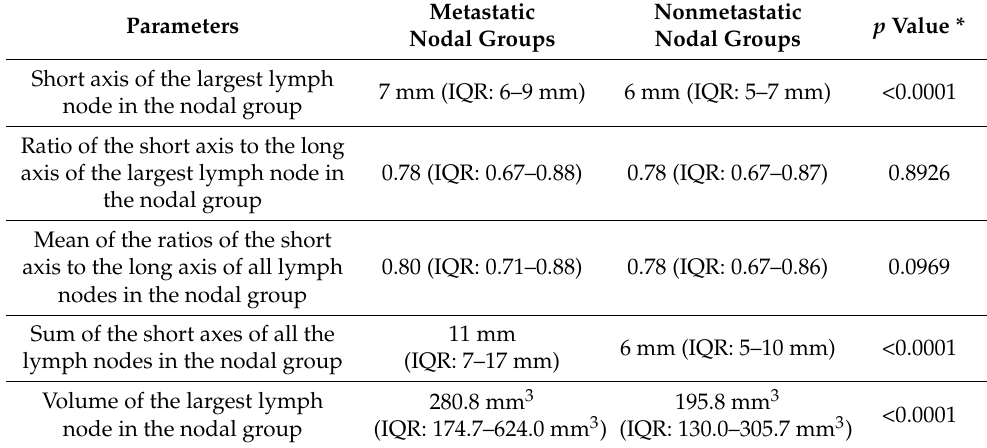
Table 3. Comparison of lymph node measurements on CT between metastatic and nonmetastatic nodal